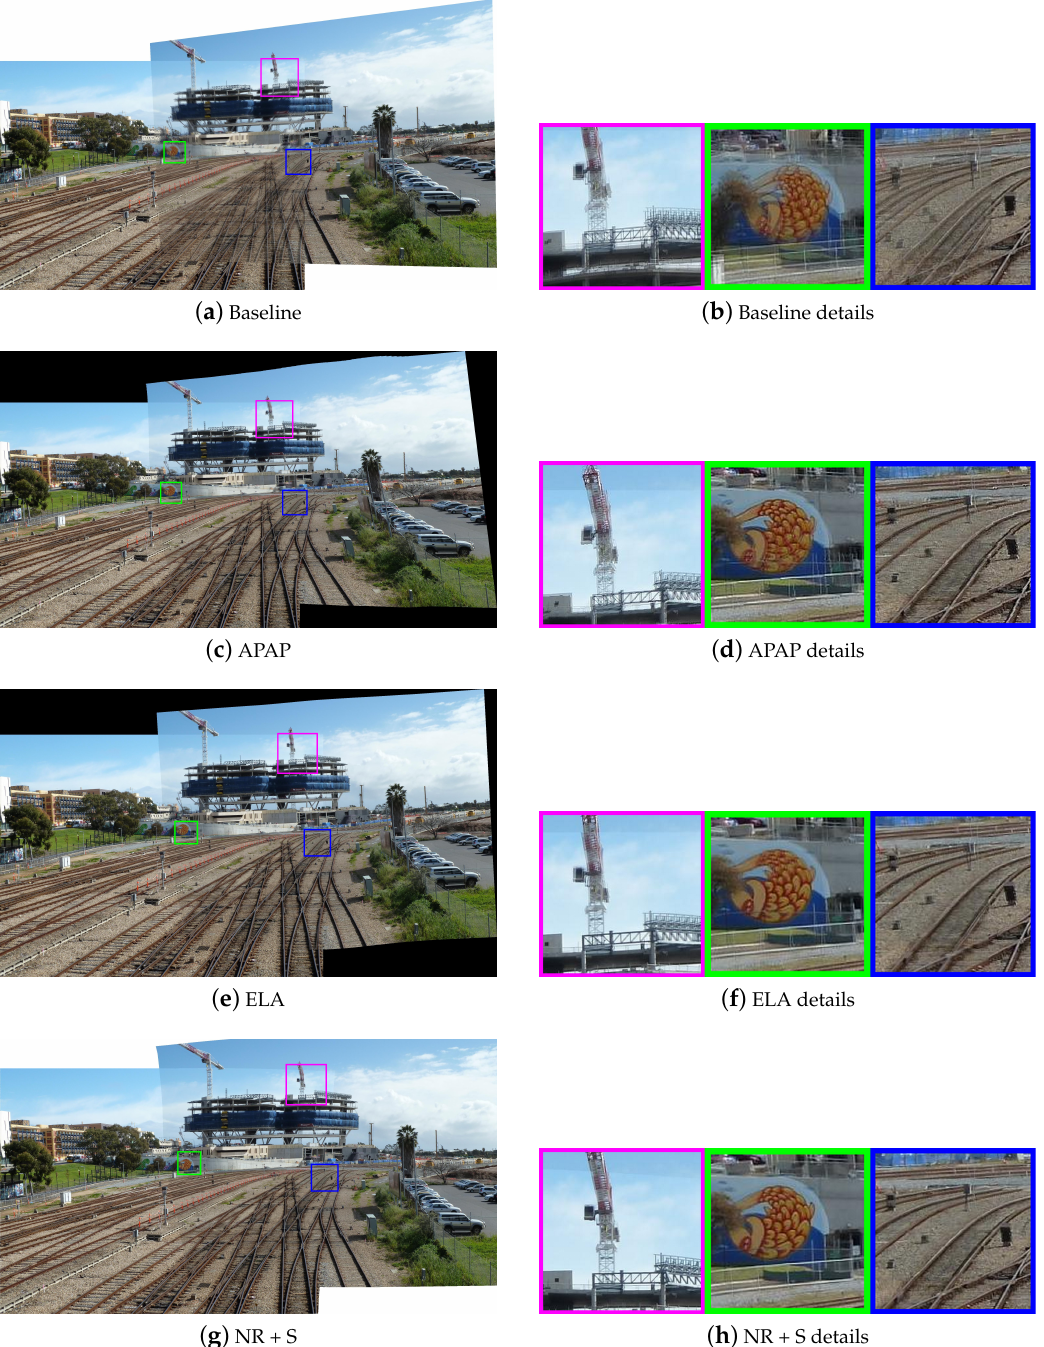
Figure 9. Comparison of stitching quality on “railtrack”. ( a , b ) are results of the baseline with obvious local misalignments. ( c , d ) are results of APAP. ( e , f ) are results of ELA. ( g , h ) are results of nonrigid + similarity